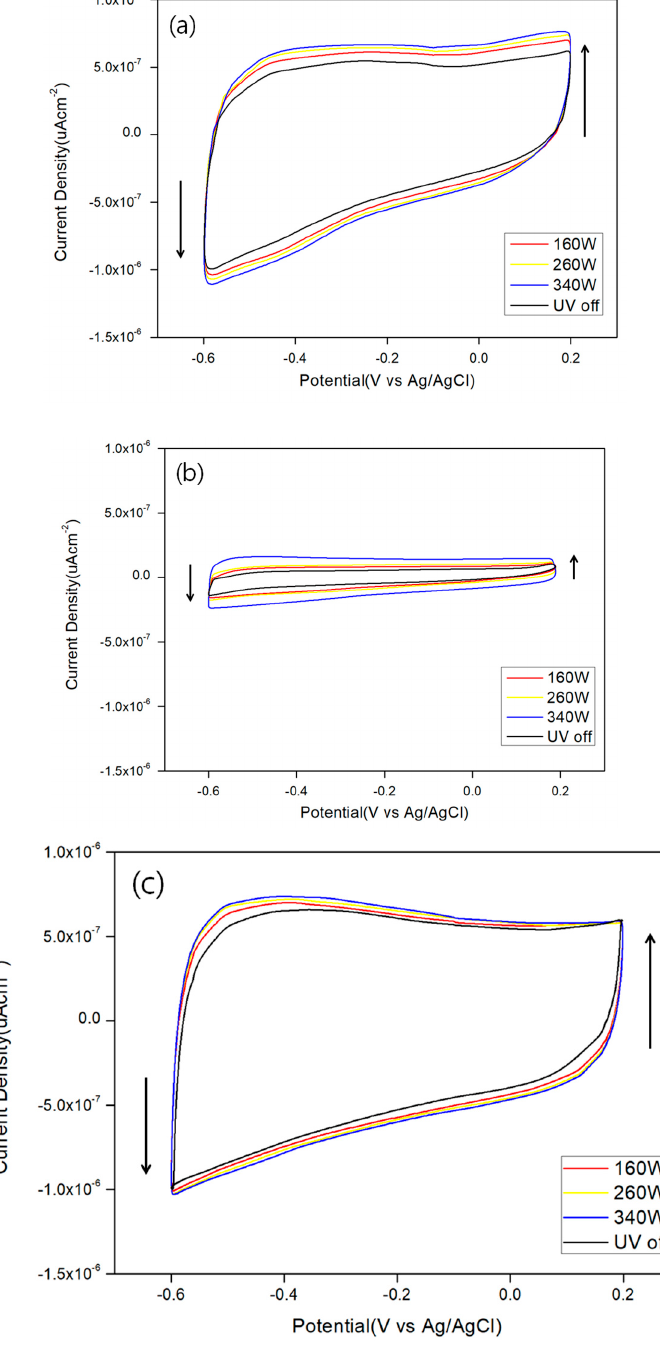
Figure 4. Cyclic voltammetry (CV) curves of red ( a ); yellow ( b ); and green ( c ) QDs under dark and light illumination with varying lamp wattages of 160, 260, and 340 W.